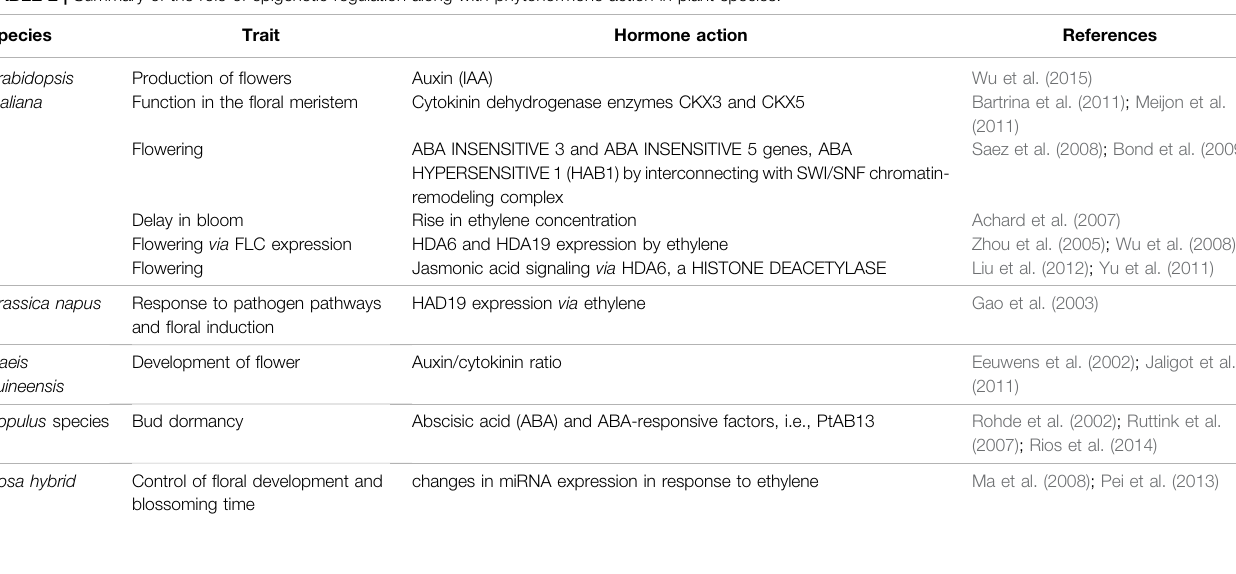
TABLE 2 | Summary of the role of epigenetic regulation along with phytohormone action in plant species. Species